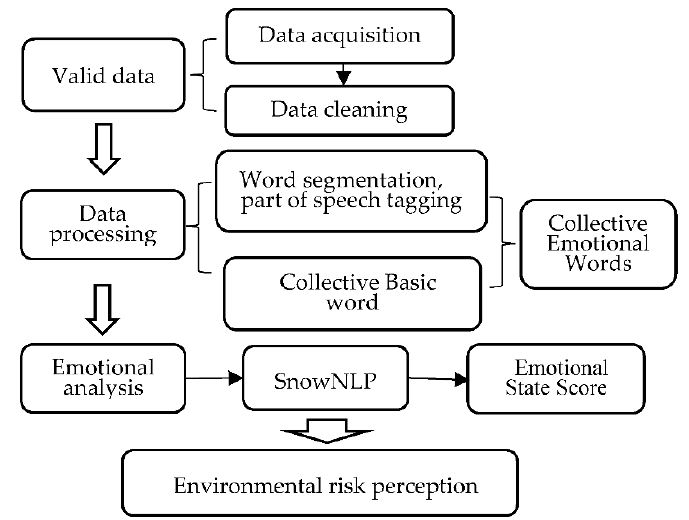
Figure 3. Data processing of environmental risk perception.